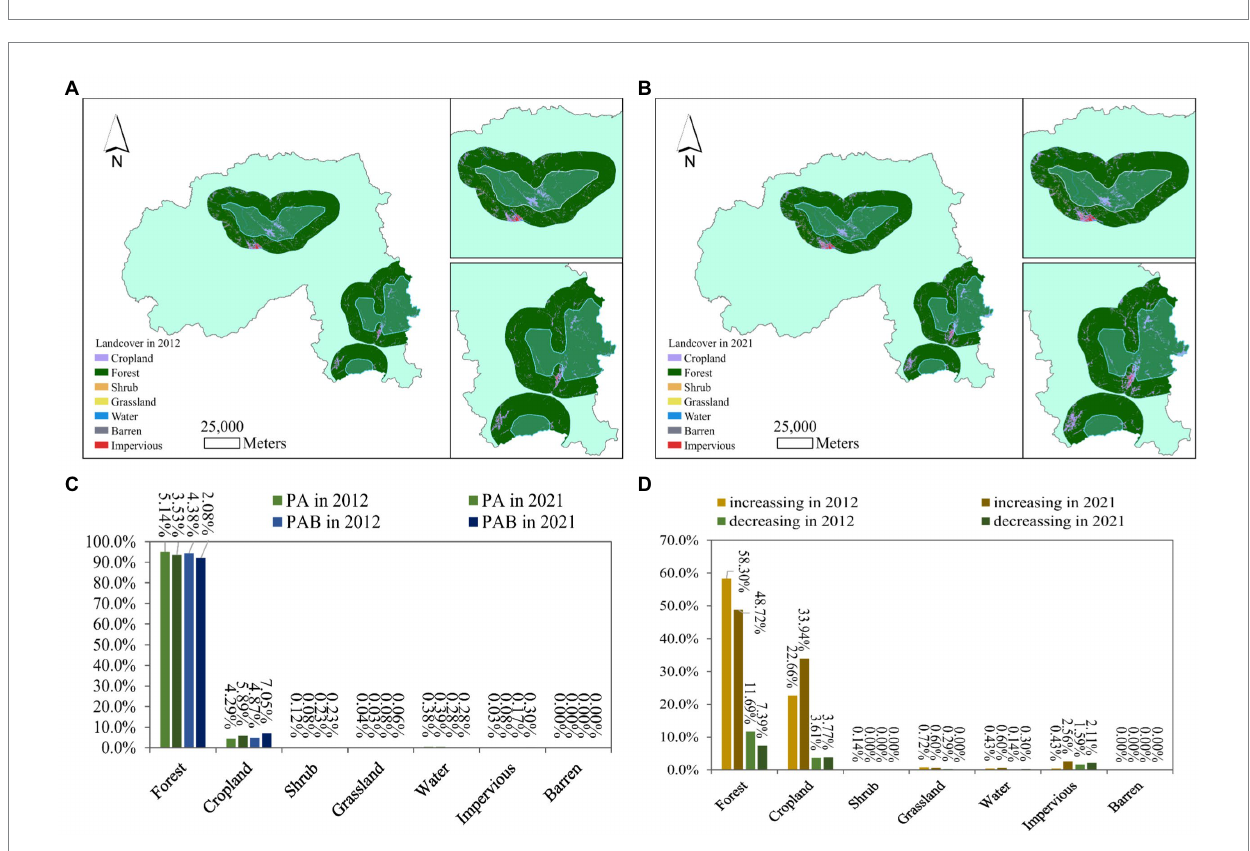
FIGURE 5 Distribution of LC types in PAB in 2012 and 2021: (A) , is the LC types in 2012; (B) , is the LC types in 2021; (C) , is the LC statistics of PA and PAB in different years; (D) , is the past trend of NTL under different LC in different